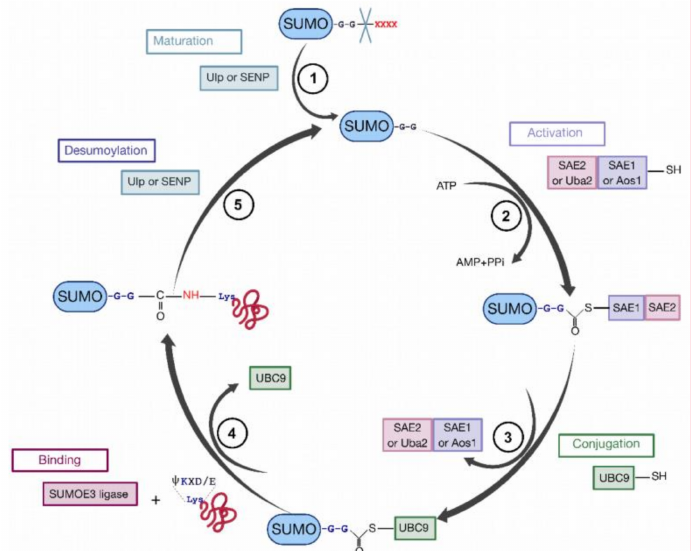
Figure 7. The cycle of sumoylation. This modification is catalyzed by different enzymes and consists in ligation of SUMO protein to K residues of protein substrates. ( 1 ) SUMO is maturated by Ub-like specific protease 1 (Ulp1) or human sentrin-specific protease 1 (SENP1). This proteolytic cleavage exposes the C-terminal GG motif required for the activation step. ( 2 ) SUMO is activated by a heterodimer composed with SAE1/SAE2 (Aos1/Uba2) to form the SUMO (E1/E2)-activating enzyme. Heterodimer is bound via a thioester bond between the C-terminal G residue of SUMO and the catalytic C of SAE2. ( 3 ) SUMO is transferred to the catalytic C of SUMO-conjugating enzyme E2 (or Ubc9) by a transesterification reaction. ( 4 ) SUMO is bound to the target protein by Ubc9 in association with SUMO E3 ligase. Ubc9 forms an amide bond between the SUMO C-terminus and ε -amino groups of the acceptor L residues in the target protein. ( 5 ) These reactions are reversible by means of the Ulp or SENP